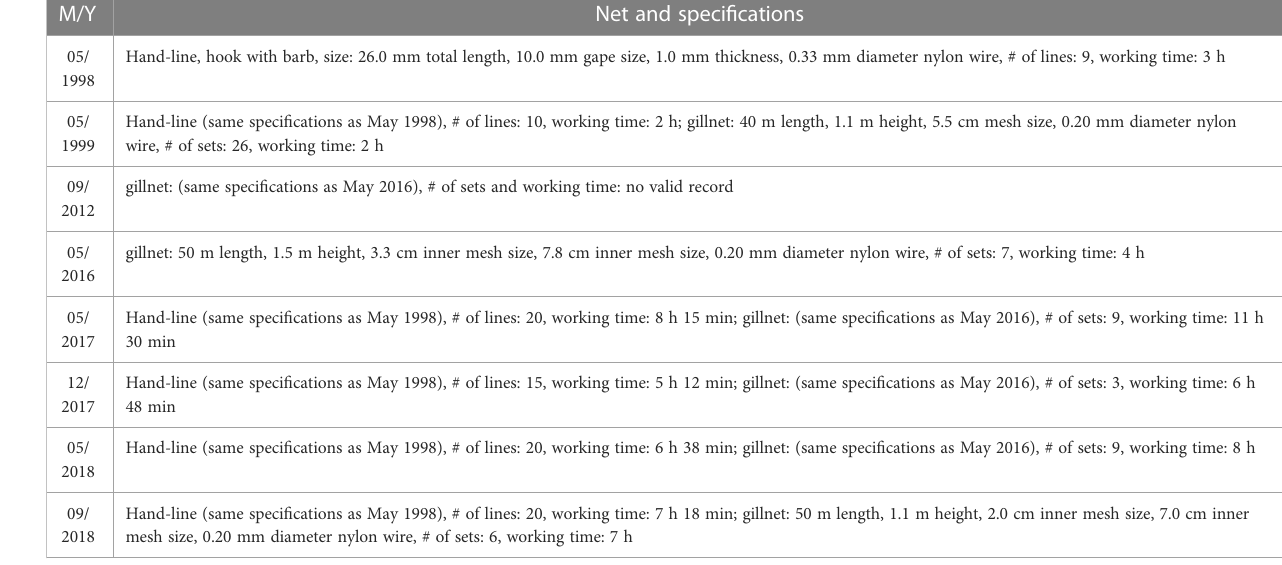
Maximum total length of fi sh was obtained from FishBase (Froese and Pauly, 2020). According to the maximum total length, fi shes were divided into three types, namely small-sized fi sh: maximum total length< 35 cm, medium-sized fi sh: 65 cm > maximum total length ≥ 35 cm, large-sized fi sh: maximum length ≥ 65 cm (Wang et al., 2022). We analyzed difference of fi sh size between 1998 — 1999 and 2016 — 2018. The species number and